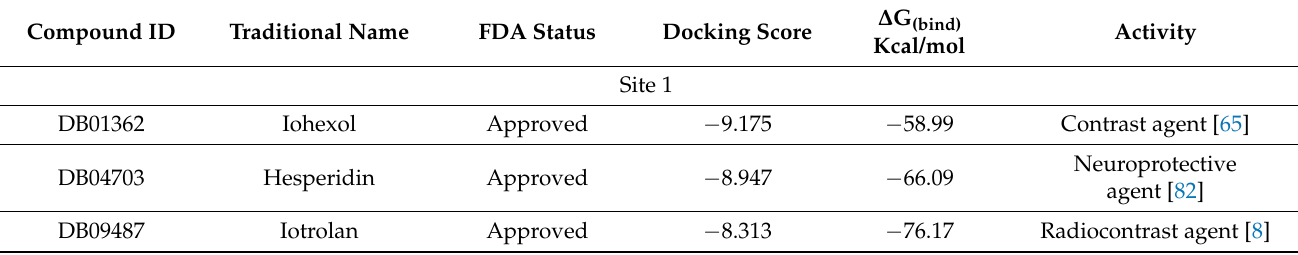
Figure 2. Viomycin protein–ligand interaction along the 100 ns simulation. Frequency of hydrogen bonding interactions ( A ); water-mediated hydrogen bonding interactions ( B ); hydrophobic interactions ( C ); representative picture of root mean square deviation (RMSD) values of protein backbone for the protein–viomycin complexes ( D ); ligand RMSD variation along the simulation time for viomycin ( E ). Table 2. Docking scores and binding-free energy calculations of the 15 best-ranked FDA-approved drugs against SARS-CoV-2’s the spike glycoprotein (S